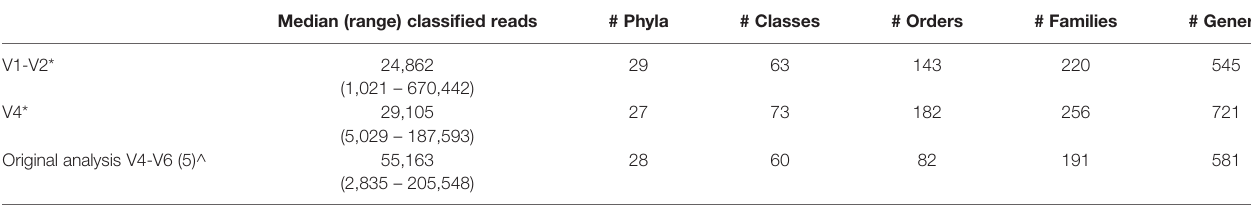
TABLE 1 | Sequencing data & Recovered taxa.